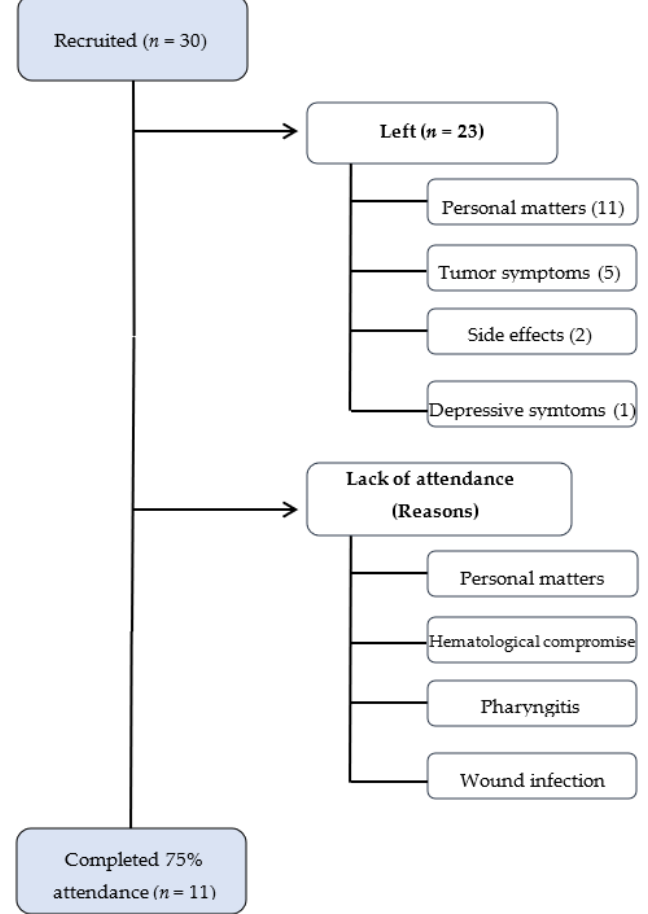
Figure 1. Flowchart from compliance.